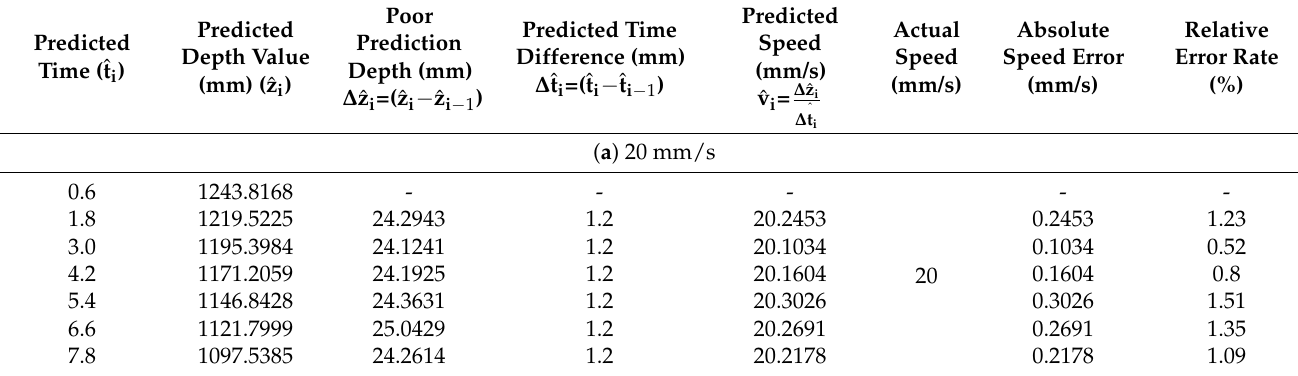
Table 4. Results of speed prediction error